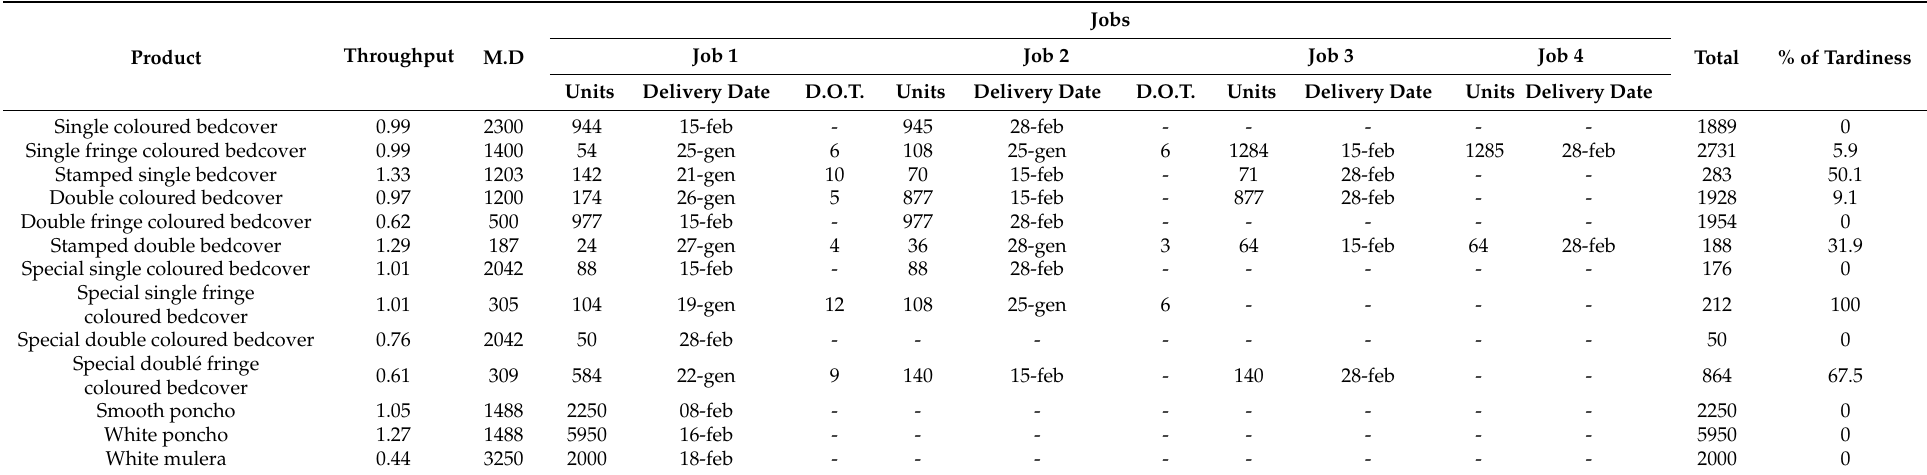
Table A2. Demand schedule and characterization of orders in terms of throughput, monthly demand, quantity, due date, DOT, and % of